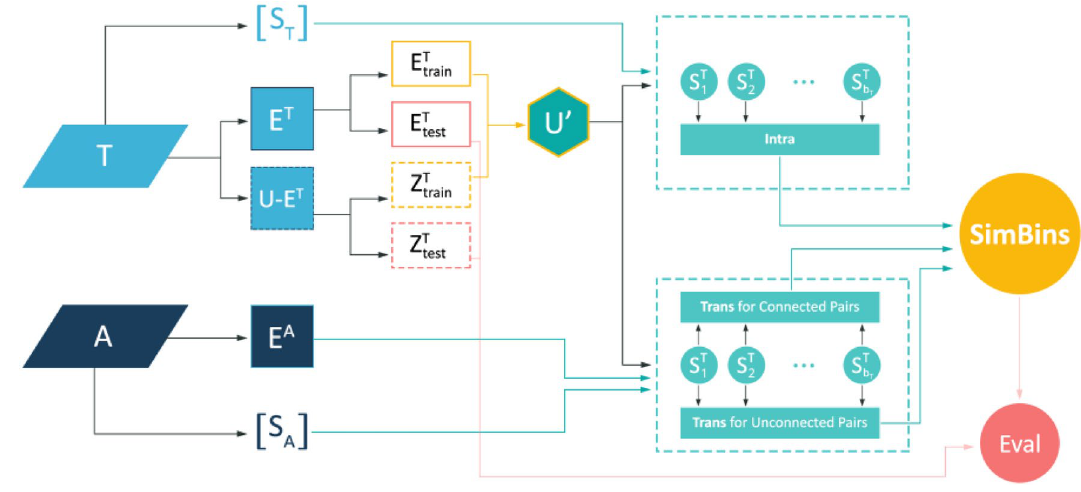
Figure 4. An overview of simbins